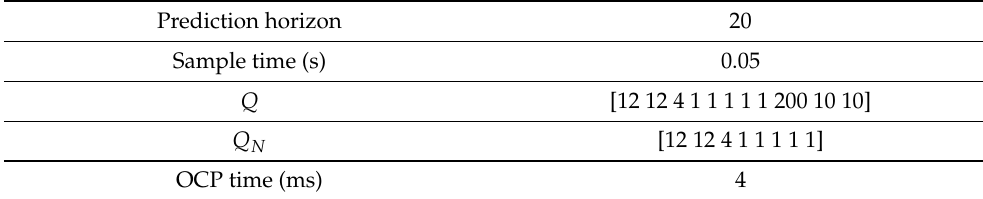
Table 2. Proposed NNMPC Parameters and OCP Performance.